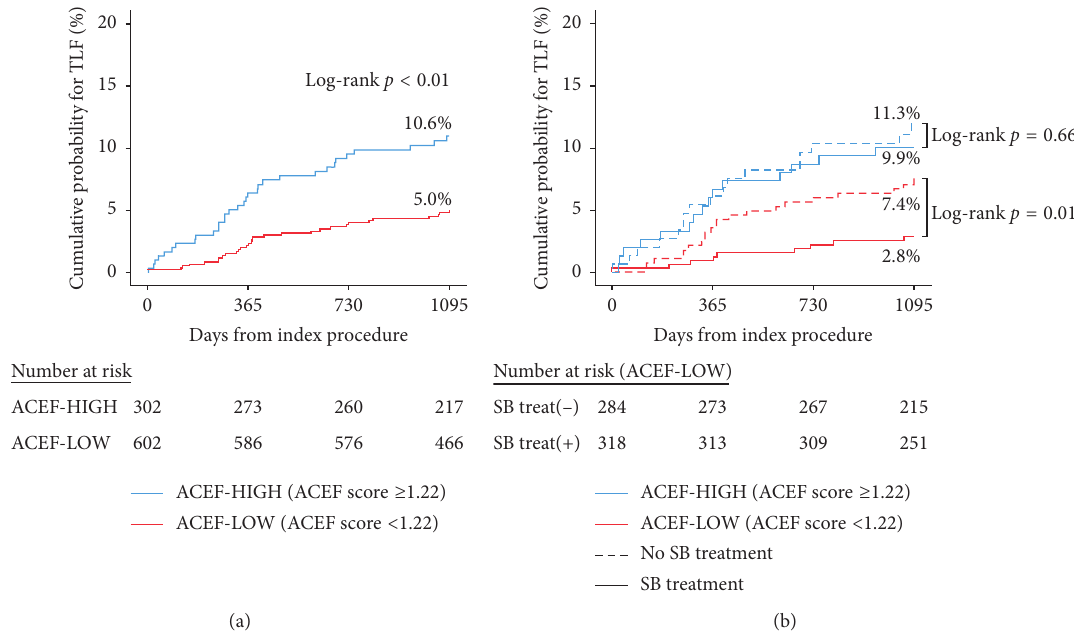
Figure 2: Kaplan–Meier curves for 3-year TLF according to the (a) ACEF risk group and (b) side-branch treatment. TLF, target lesion failure; ACEF, age, creatinine, and ejection fraction score; and SB, side